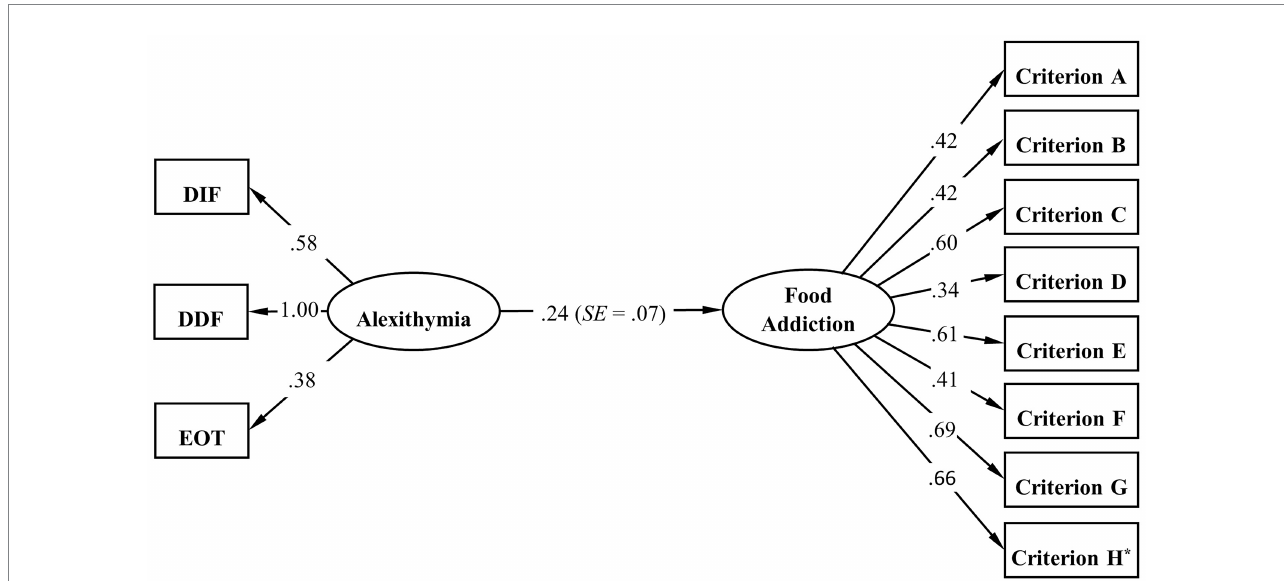
FIGURE 2 Standardized estimation results of SEM for the associations between alexithymia and food addiction. *The loading of criterion H has a binomial